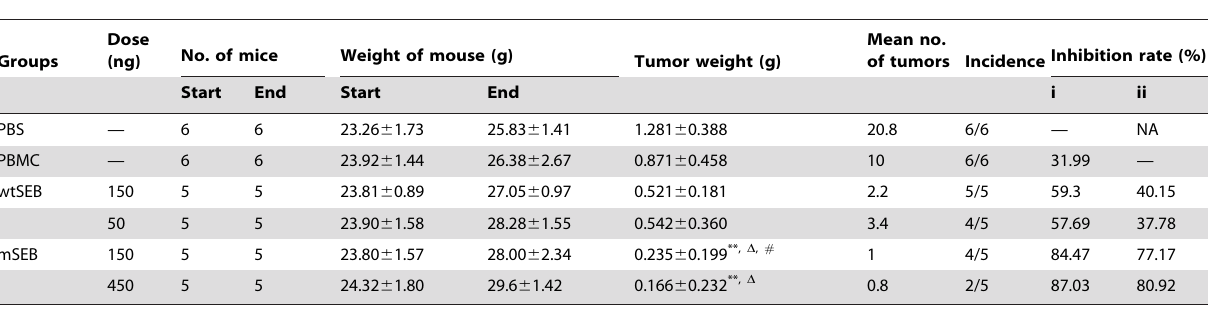
Data represent the mean 6 SD. The results shown are representative of duplicate experiments. NA stands for not available. Comparison versus PBS controls: ** P , 0.01. Comparison versus PBMC group: D P ,